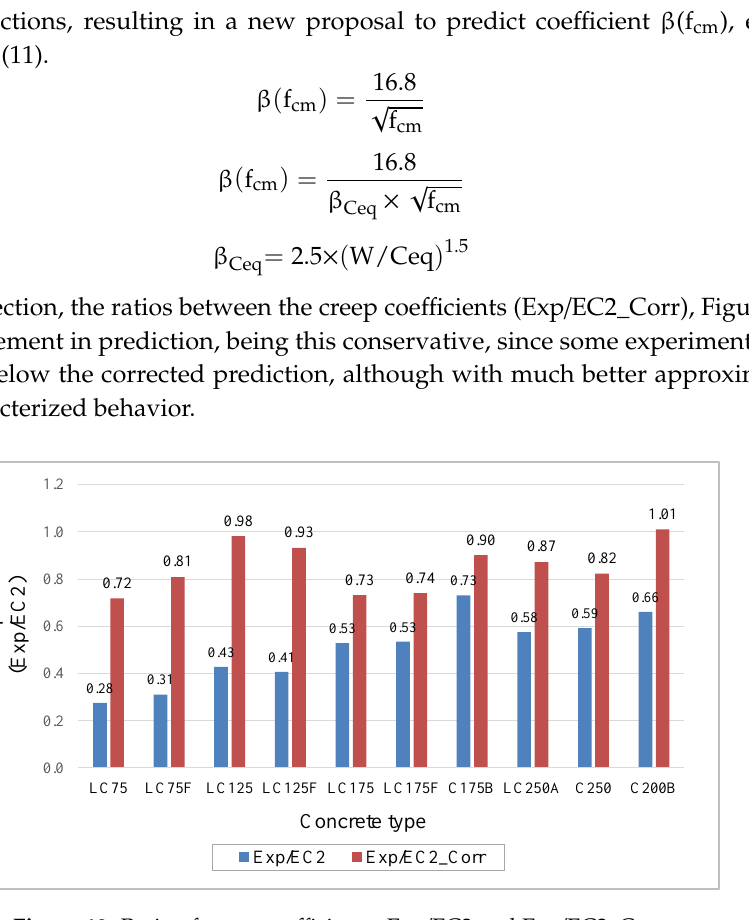
Figure 10. Ratio of creep coefficients: Exp/EC2 and Exp/EC2_Corr.